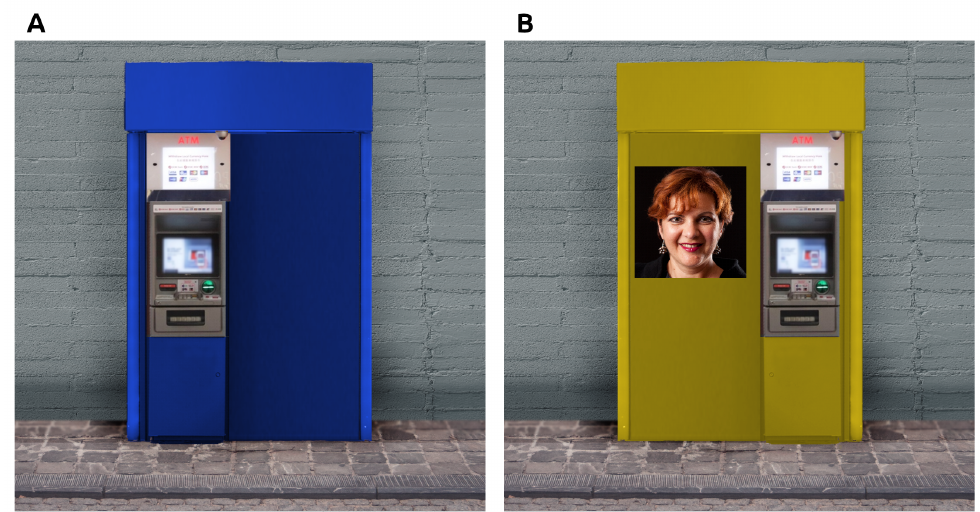
Figure 1. Examples of images employed in this study. ( A ): example of ATM with interface on the left side, with no faces added. ( B ): example of ATM with interface on the right side, with a face placed on the left